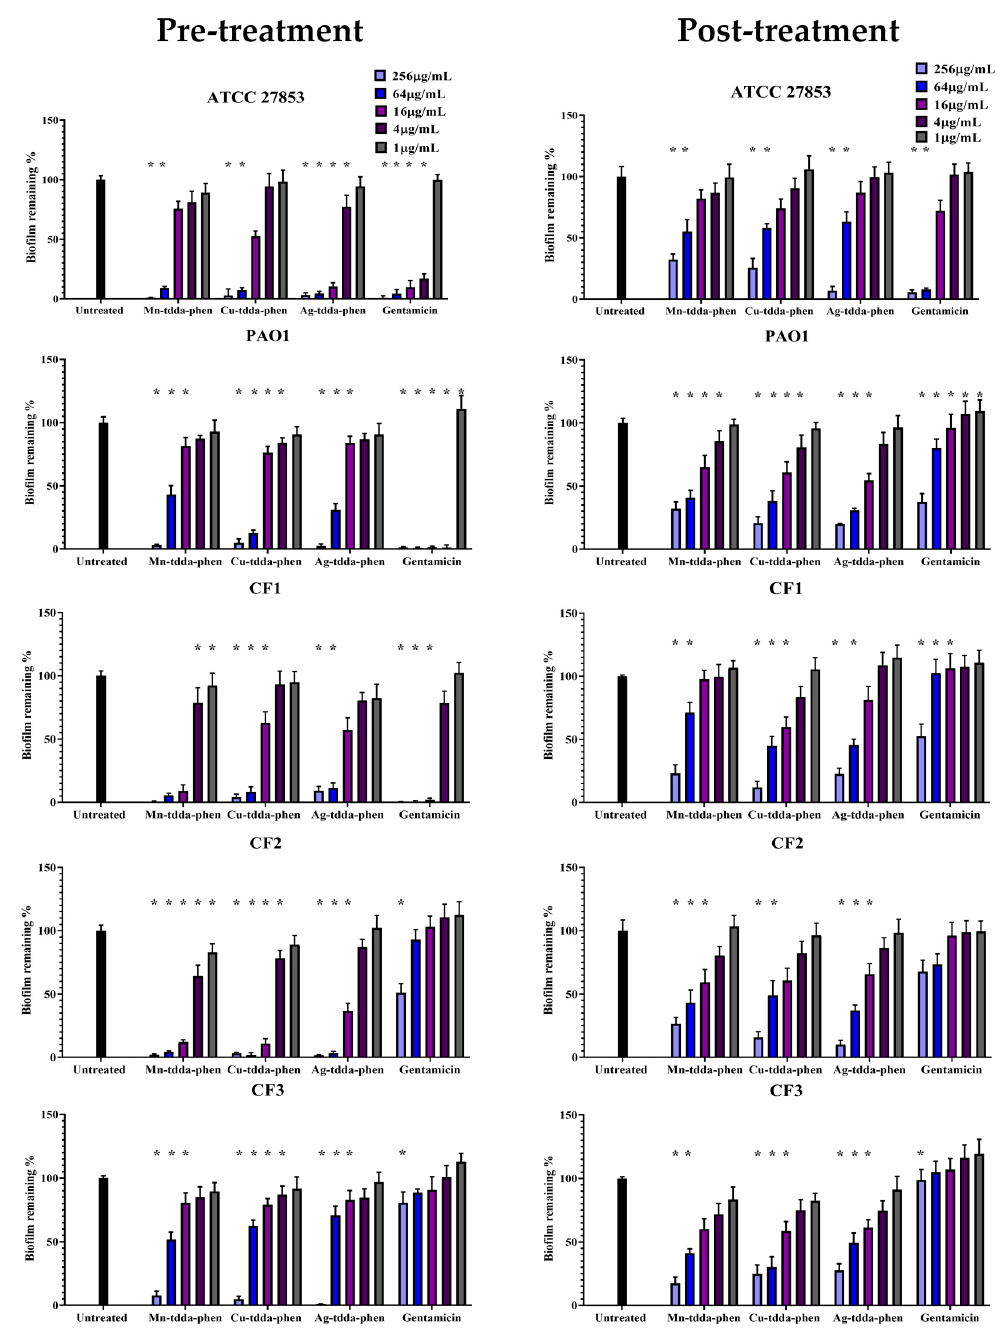
Figure 2. Biofilm biomass— Effect of metal-phen complexes (Mn-tdda-phen, Cu-tdda-phen and Ag-tdda-phen) and gentamicin on both inhibiting biofilm formation (pre-treatment) and dismantling established biofilms (post-treatment) of laboratory strains (ATCC 27853 and PAO1) and clinical isolates (CF1–CF3). Asterisks indicate significance ( p > 0.05) relative to the untreated control.